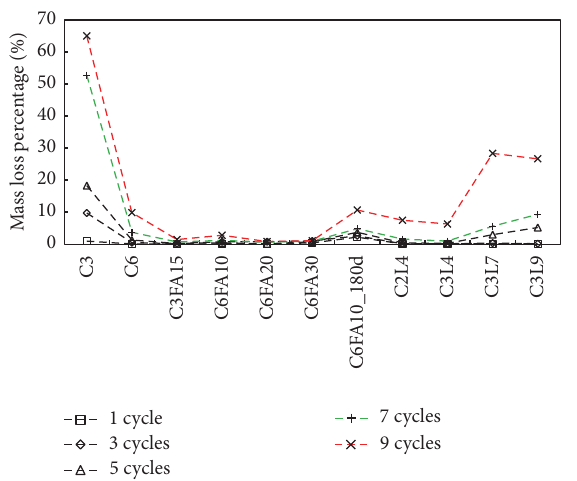
Figure 10: Mass loss percentage of stabilized samples after frost actions.